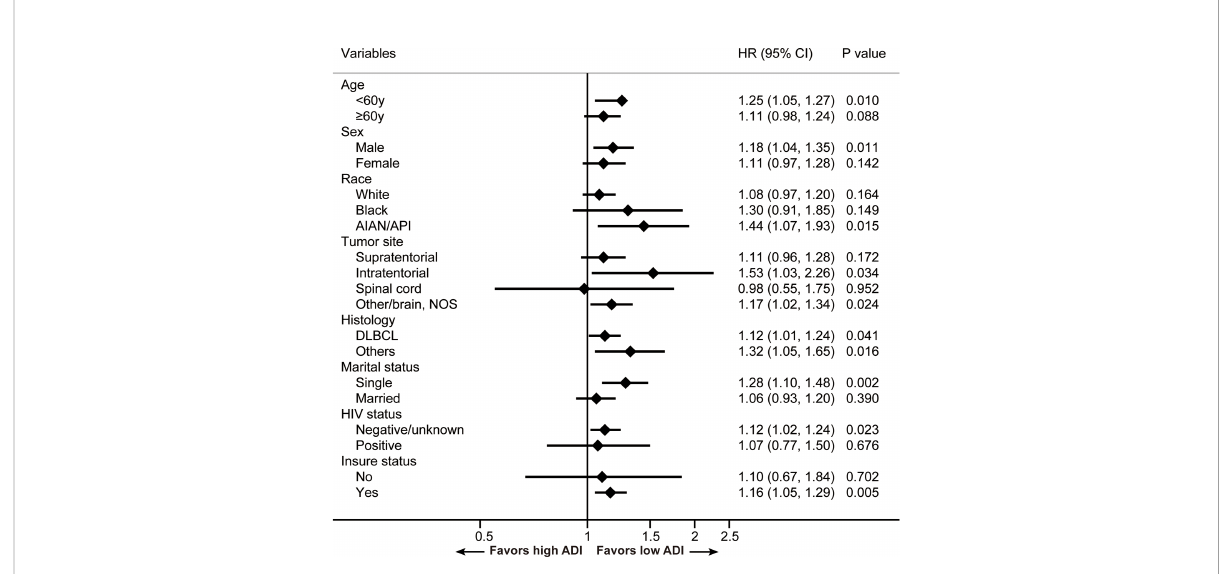
FIGURE 3 Results for the subgroup analyses for cancer-speci fi c survival are summarized in a forest plot. AIAN/API, American Indian/Alaska Native or Asian Paci fi c Islander; DLBCL, diffuse large B-cell lymphoma; NOS, not otherwise speci fi